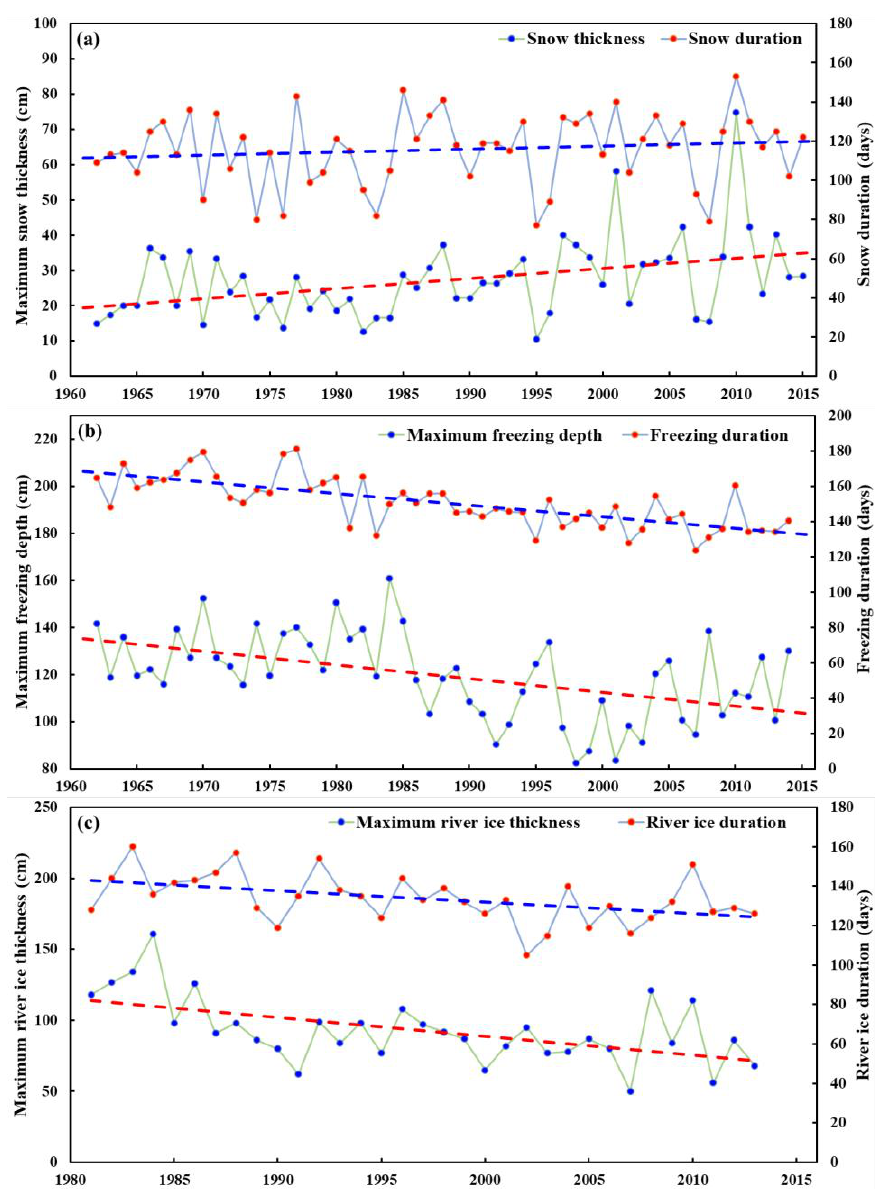
Figure 3. SAM Variations in ( a ) snow cover and ( b ) SFG during the period 1961–2015 observed by CMA, and in ( c ) river ice during the period 1981–2013 observed by the Ministry of Water Resources of the People’s Republic of China.